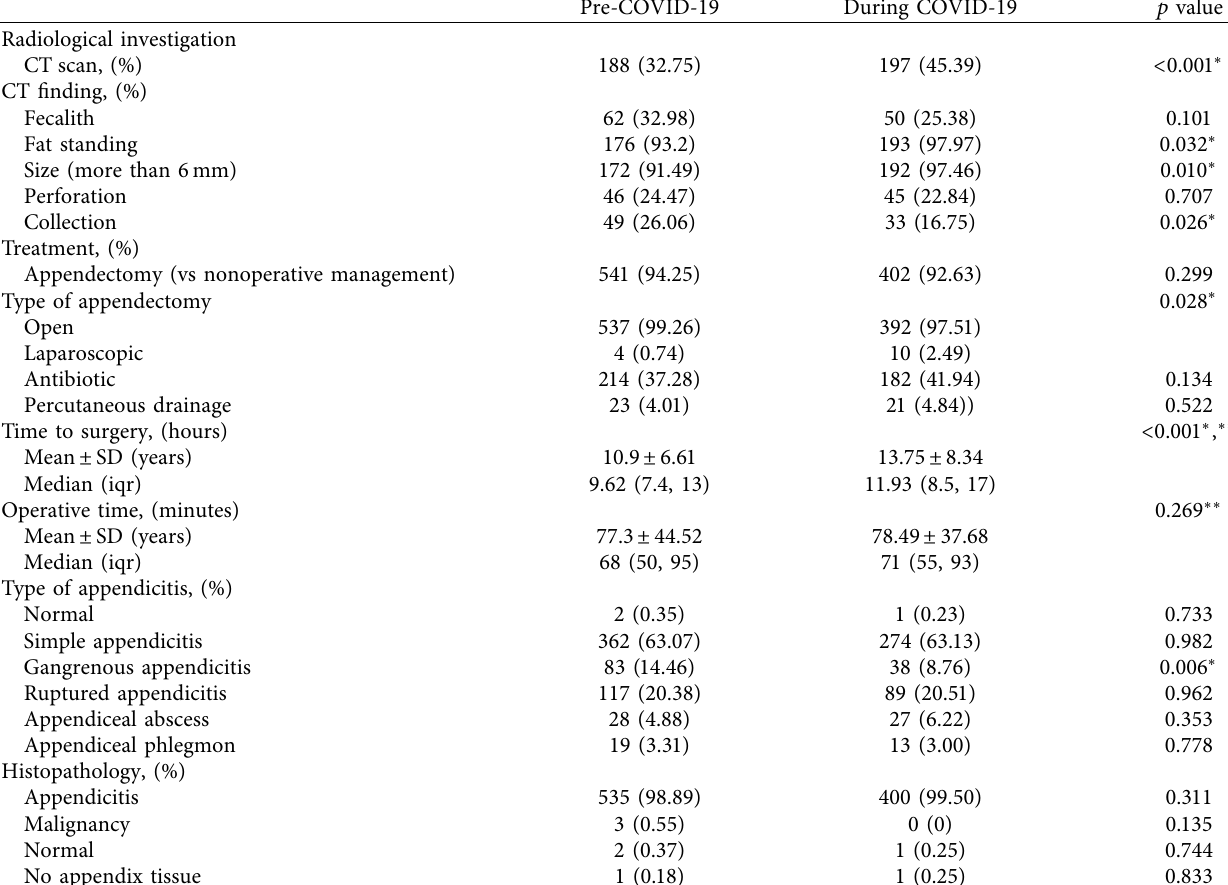
Table 2: Investigation, operative, and histopathology data of adult patients with acute appendicitis.